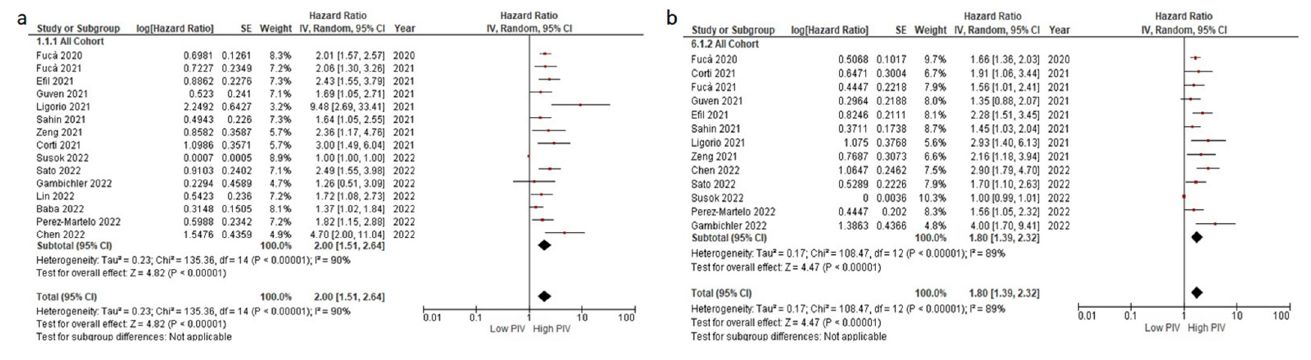
Figure 1. The association between PIV levels and OS ( a ) and DFS/PFS ( b ). Lines ( ○ ) indicate 95% CIs. Diamond ( ♦ ) indicates the pooled effect size.